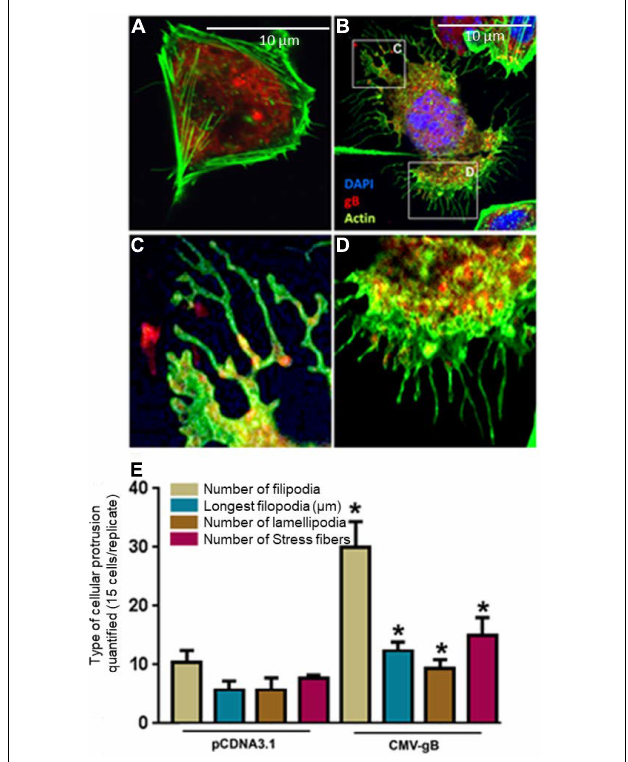
FIGURE 2 | Expression of HCMV glycoprotein B (gB) leads to the induction of cellular protrusions in Chinese hamster ovary (CHO-K1) cells. (A) CHO-K1 cells transfected with pDS-Red encoding pCDNA3.1 (2.0 µ g) plasmid using lipofecatamine-2000. Cellular actin was stained using (Alexa fluor R (cid:13) 488; Invitrogen) for visualizing filopodia. (B) CHO-K1 cells transfected with 2.0 µ g HCMV gB tagged with pDS-Red. The boxed region in (B) is highlighted in (C,D) . (C) Showed the presence of HCMV gB on the tips of the filopodia, while (D) shows extensive gB clustering inside cell at the base of filopodia. (E) Quantification of cellular protrusions (filopodia, length, lamellipodia, and stress fibers) is being compared between CHO-K1 cells expressing pCDNA3.1 and CHO-K1 cells expressing HCMV gB. The quantifications are based on 15 cells randomly picked per triplicate experiment. Asterisks indicate significant difference from controls and/or treatments ( p < 0.05, t -test), and error bars represent